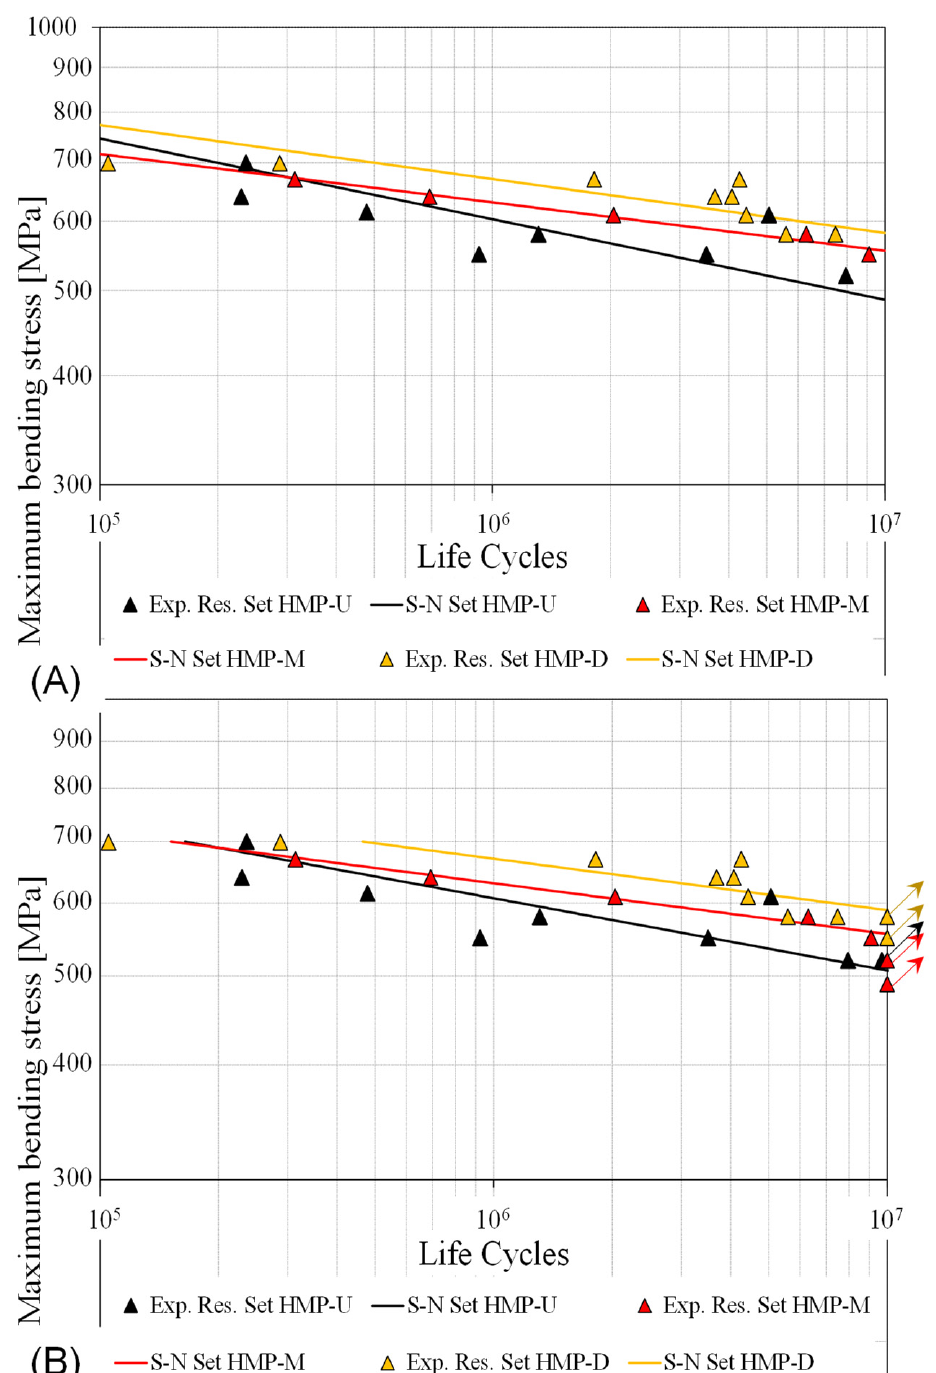
Figure 6. Fatigue curves in the finite life domain for the investigated data sets, ( A ) according to ISO 12,107 [29] and its linear regression model (runouts are omitted here, because they are not used for interpolation) and ( B ) complying with the MLE method (runouts are highlighted by slanted arrows). Then, an SSBC (cid:48) term, i.e., a term being related to the effect of the considered factor, must be determined as in Equation (5). This term can be regarded as the sum of the squares of the differences between strengths for each curve and the corresponding strength for the same value of lifecycles, according to the aforementioned grand-mean curve. From this point of view, it is a reliable indicator of the different trends and distances among